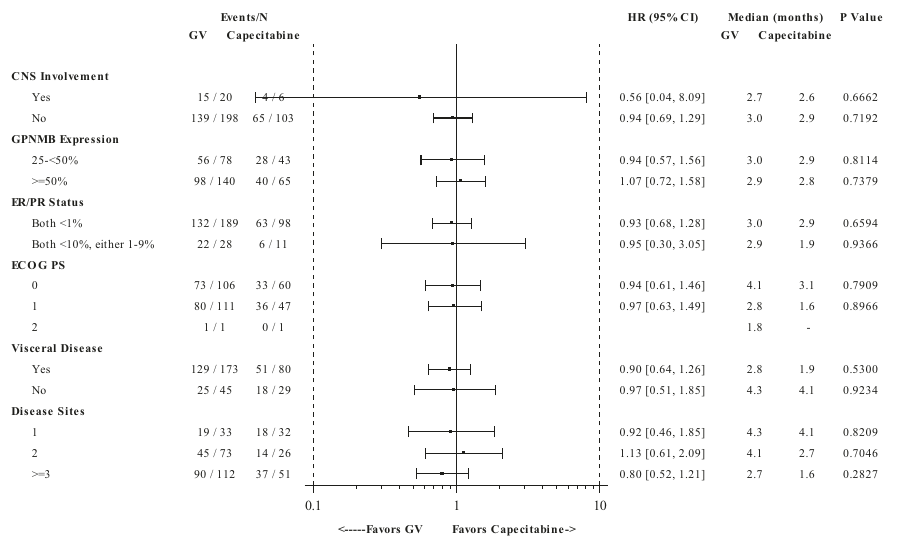
Fig. 5 Progression-free survival by baseline disease characteristics. Progression-free survival was determined in the intention-to-treat population, based on Independent Review Committee assessments. A forest plot for progression-free survival for GV compared with capecitabine is shown by baseline disease characteristics. The black square represents the hazard ratio while the odds ratios (95% CIs) are denoted by black and by the progression-free interval after last taxane received ( ≤ 6 vs. >6 months). Patients were randomly assigned (2:1) to the treatment groups using a pre-speci fi ed randomization sequence, block size of 6, via interactive response technology. As this was open-label, there was no masking of trial participants or investigators. The IRC and biostatistical team at the study sponsor were masked to treatment assignments until after study closure.